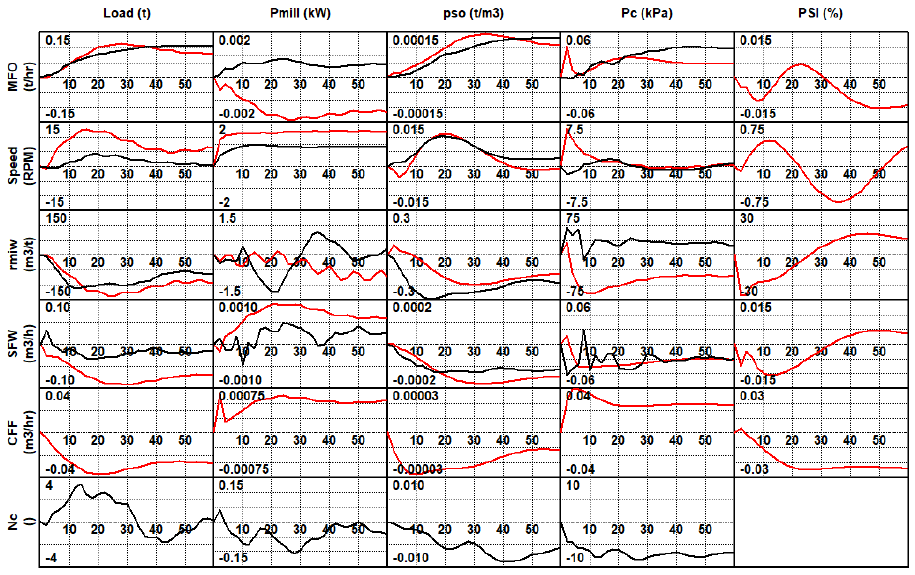
Figure 10. Linear time- invariant models from planned step tests (red) and DQA data (black).